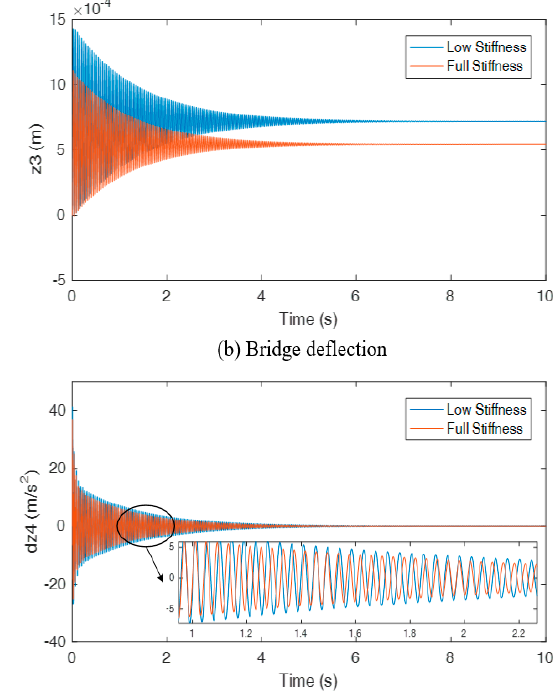
Figure 3. Dynamic response of the system with different loads.